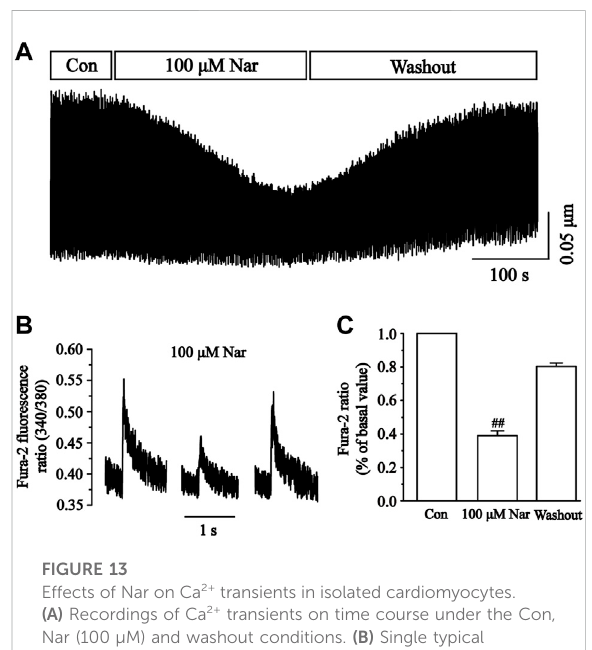
FIGURE 13 Effects of Nar on Ca 2+ transients in isolated cardiomyocytes. (A) Recordings of Ca 2+ transients on time course under the Con, Nar (100 μ M) and washout conditions. (B) Single typical recordings of Ca 2+ transients at Con, Nar (100 μ M) and washout. (C) Summarized data at Con, Nar (100 μ M) and washout. Values were expressed as the mean ± SEM, each group has 9 cells from fi ve rat